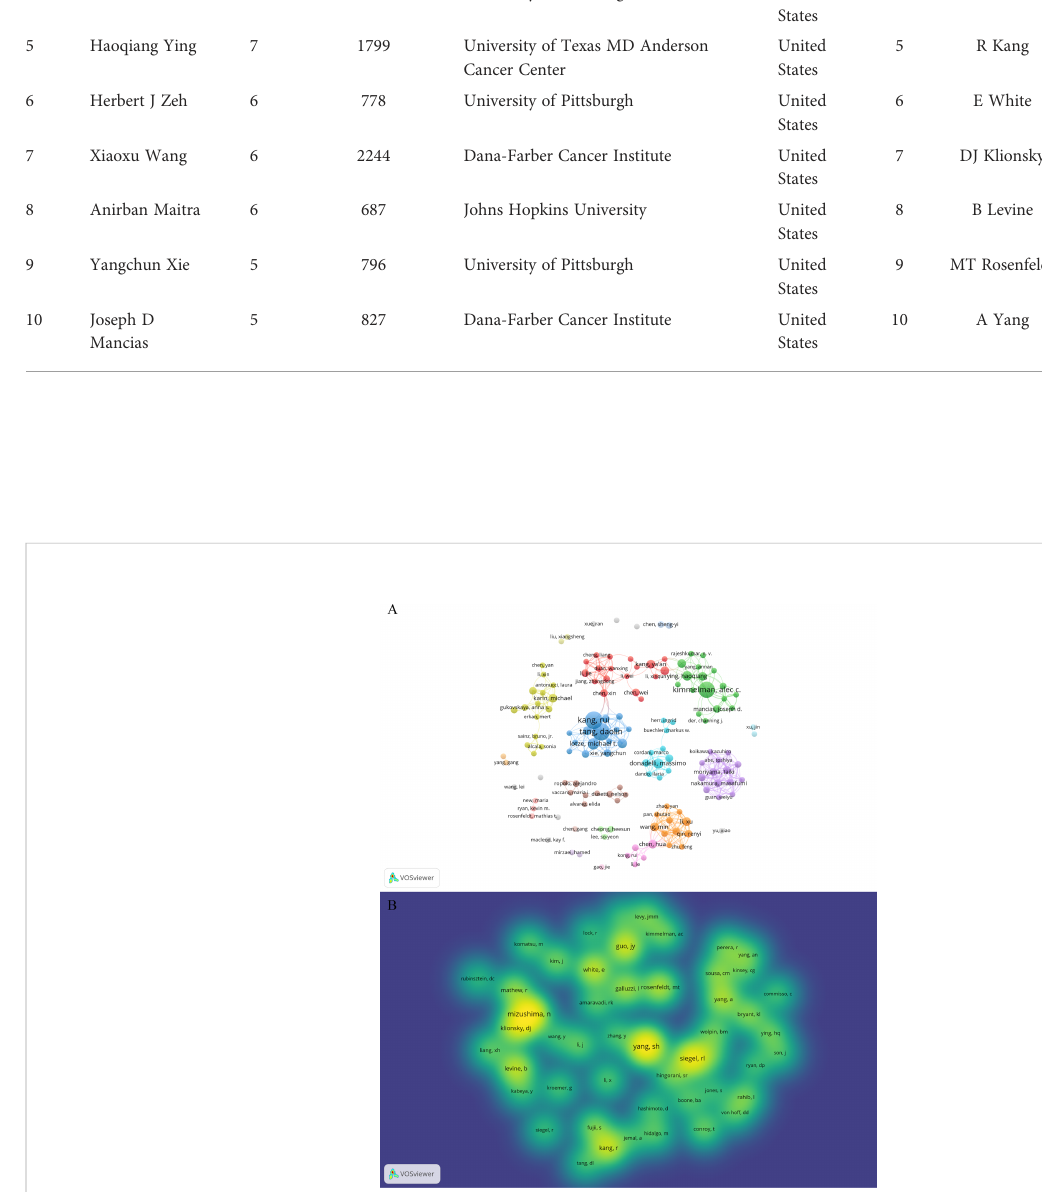
FIGURE 5 Authors and co-cited authors in the fi eld of autophagy and pancreatic cancer. (A) The co-authorship network analysis of authors. The layout parameters: Attraction: 3, Repulsion: -1. The circle size means the number of publications; the thickness of the line means the strength of the connection; the circle colors mean different clusters; (B) The density map of co-cited authors. The layout parameters: Attraction: 2, Repulsion: 1. The color brightness means the frequency of